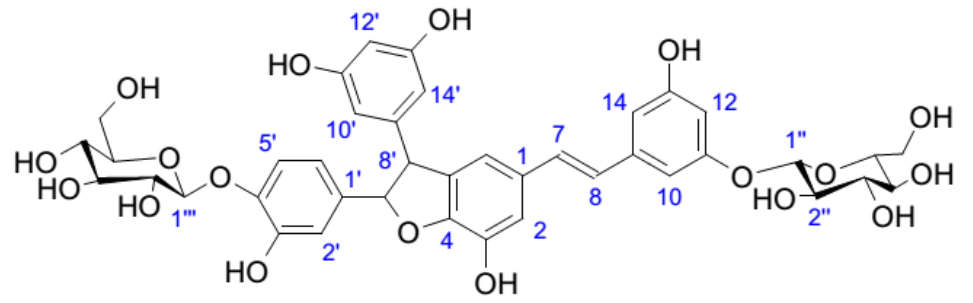
Figure 3. Chemical structure of compound 13 , piceaside V.